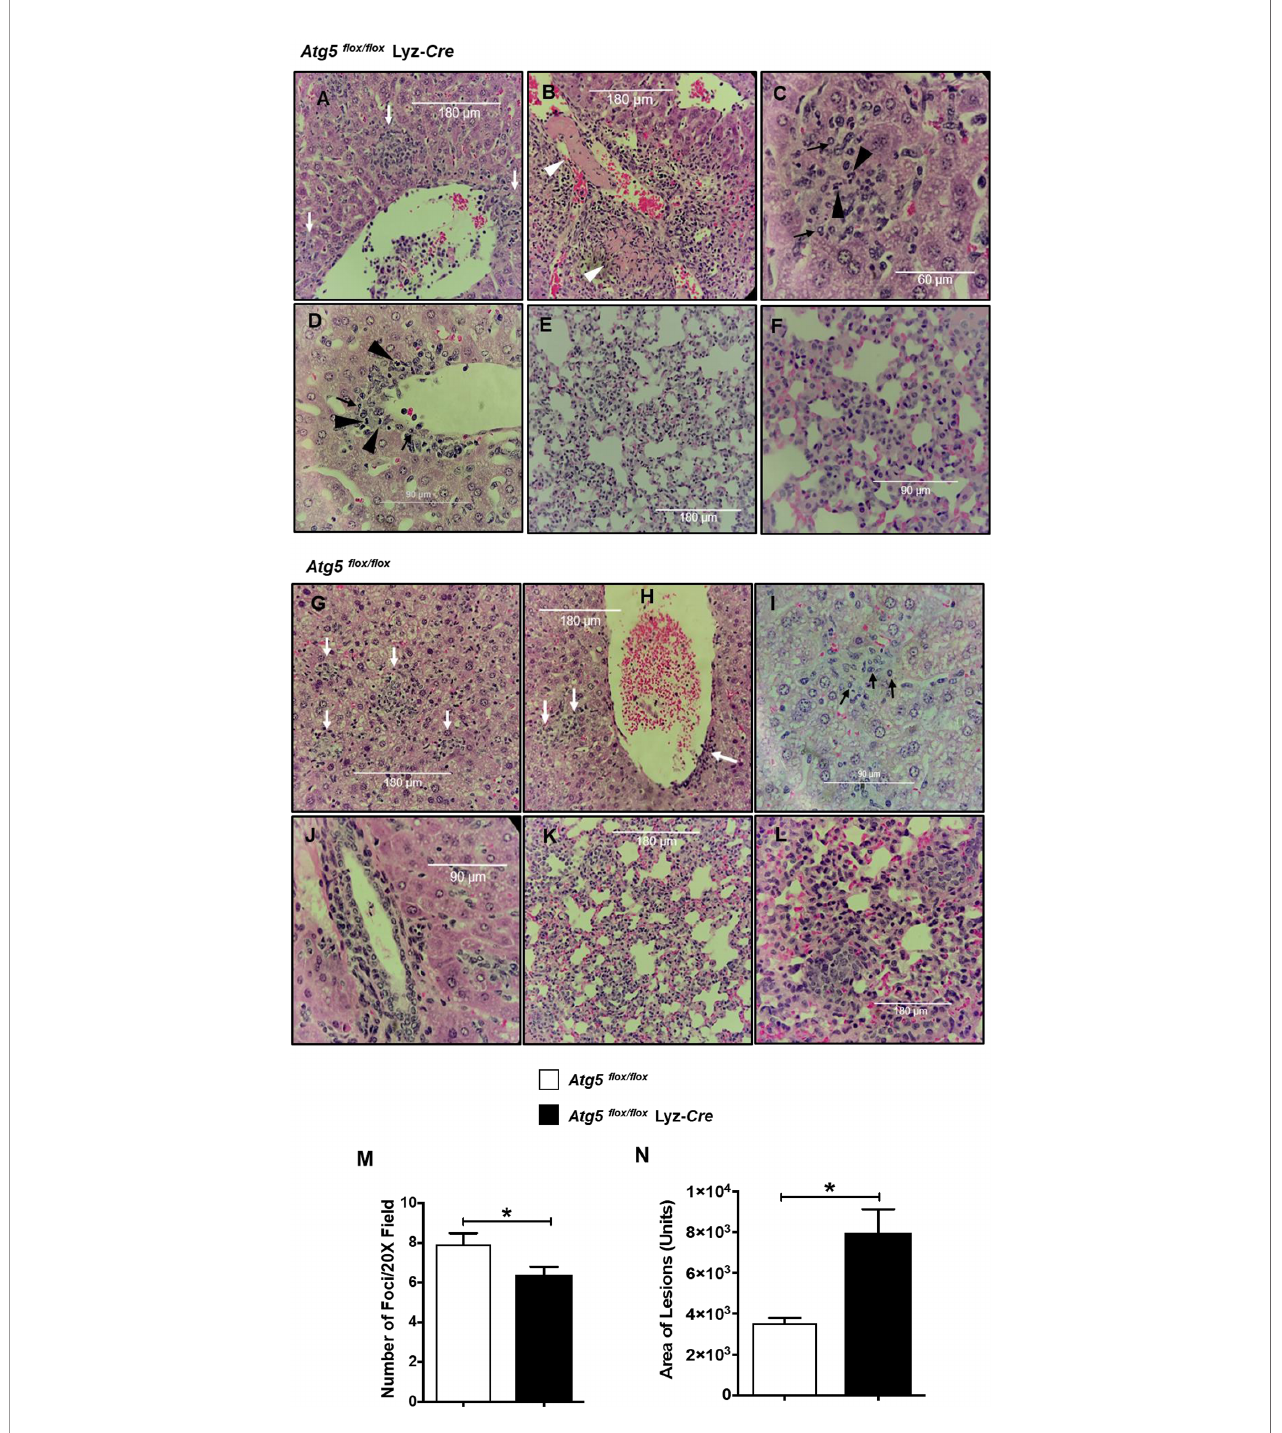
FIGURE 2 | (previous Figure 7). In fl ammatory cellular accumulation upon infection with R. australis in tissues of Atg5 fl ox/ fl ox mice and Atg5 fl ox/ fl ox Lyz- Cre mice. Mice were infected i.v. with R. australis (3 × 10 5 PFU per mouse). On day 4 p.i., mice were sacri fi ced, and tissues were isolated and analyzed. Histological analysis of livers and lungs from infected Atg5 fl ox/ fl ox Lyz- Cre mice (A – F) and Atg5 fl ox/ fl ox mice (G – L) . Foci of in fl ammatory in fi ltration are indicated by white arrows. Thrombus or necrotic cells related to thrombosis is shown as white arrowheads (B) . Polymorphonuclear neutrophils (PMNs) (black arrowheads) and macrophages (black arrows) are shown in livers. Furthermore, the size (M) and frequency (N) of in fl ammatory lesions in livers were analyzed using ImageJ (magni fi cation, ×20). Images were taken using an Olympus BX41 photomicroscope (Olympus America, Inc., Center Valley, PA) or using a Revolution Microscope and an iPad Pro ® tablet (Echo Laboratory, San Diego, CA).